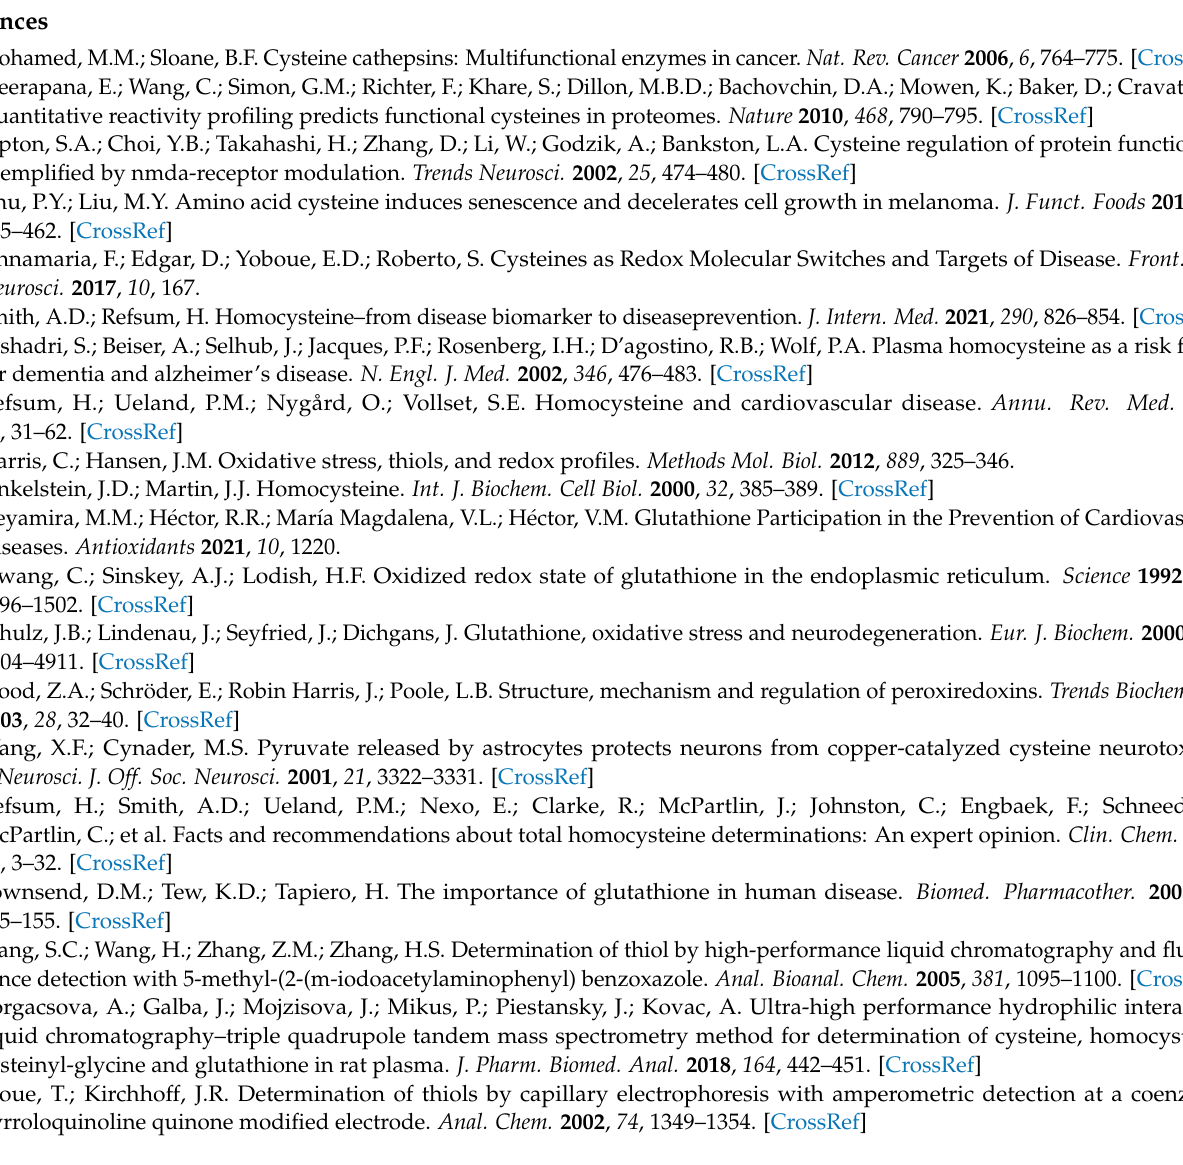
ent concentrations of SWJT-14 for 24 h; Figure S16: Optimized structure of SWJT-14; Figure S17: Optimized structure of 5; Figure S18: Optimized structure of 6; Figure S19: Optimized structure of